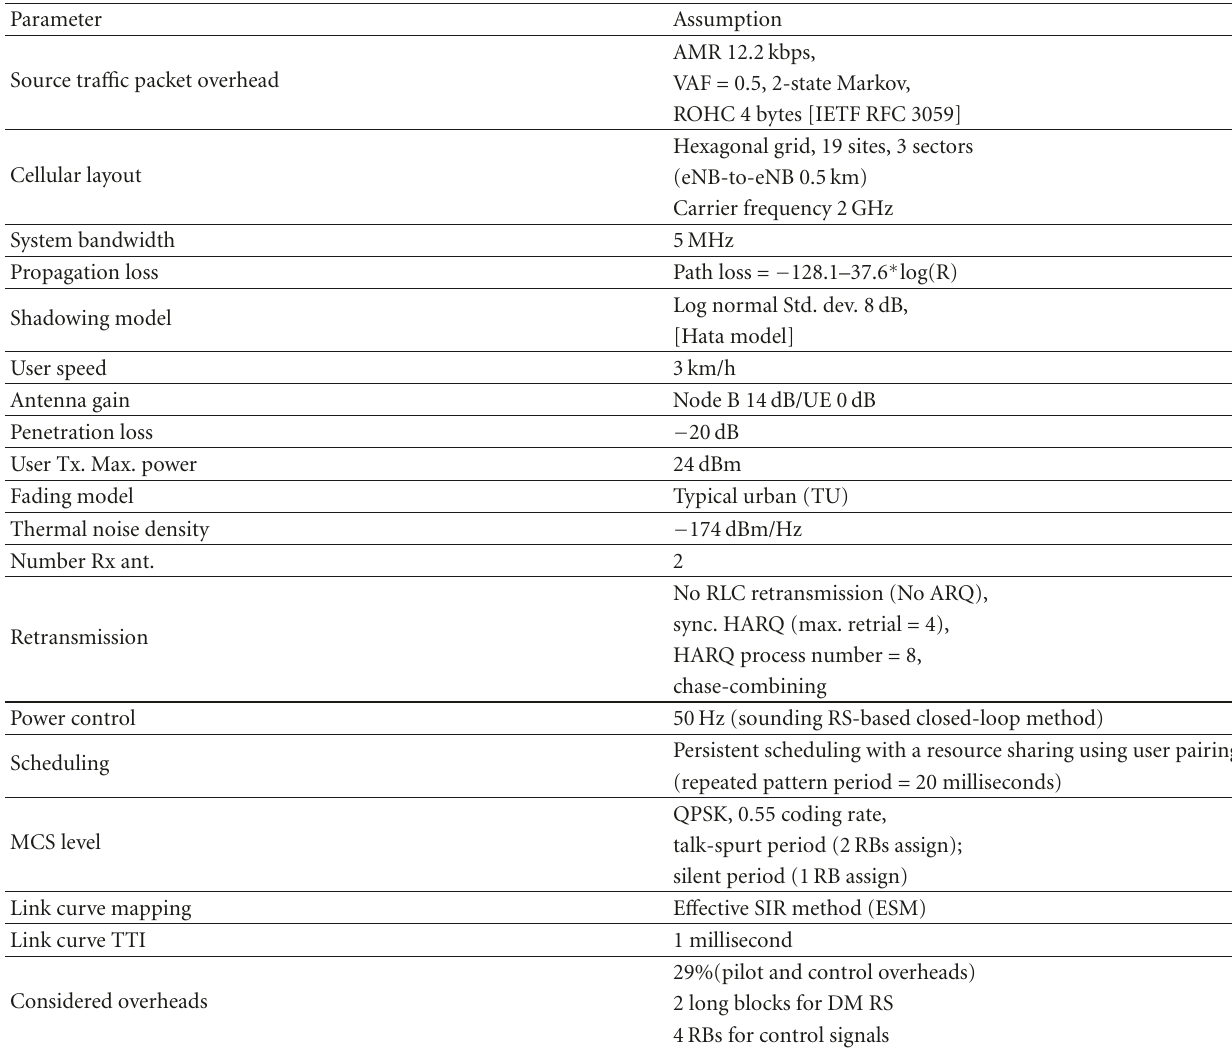
Table 2: System-level simulation